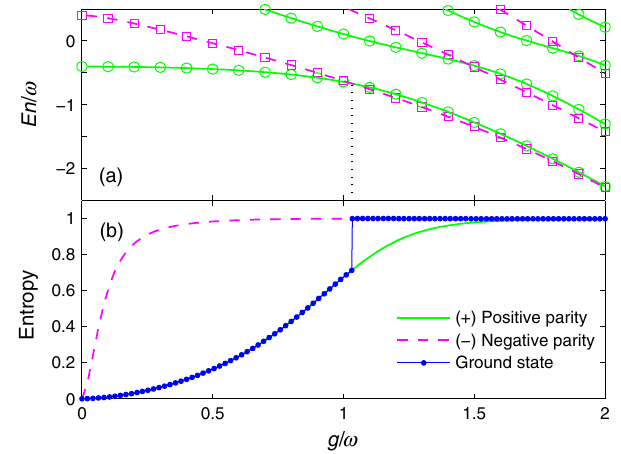
FIG. 5. Energies (upper panel) and entanglement entropies (lower panel) of the ground state and the first excited state. A ffiffiffiffiffi p 4 = 15 level crossing occurs at g , marking a change of the c ¼ parity of the ground state: for g < g , the parity is positive (solid c green line), and it is negative (dashed purple line) for g > g , as c shown in the upper panel. Correspondingly, we find that the ground-state entropy displays a sharp discontinuity at the level-crossing point, as shown in the lower